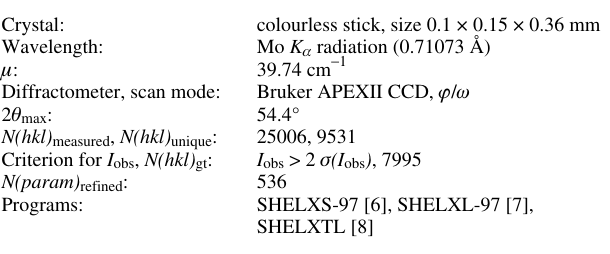
Table 1. Data collection and handling.